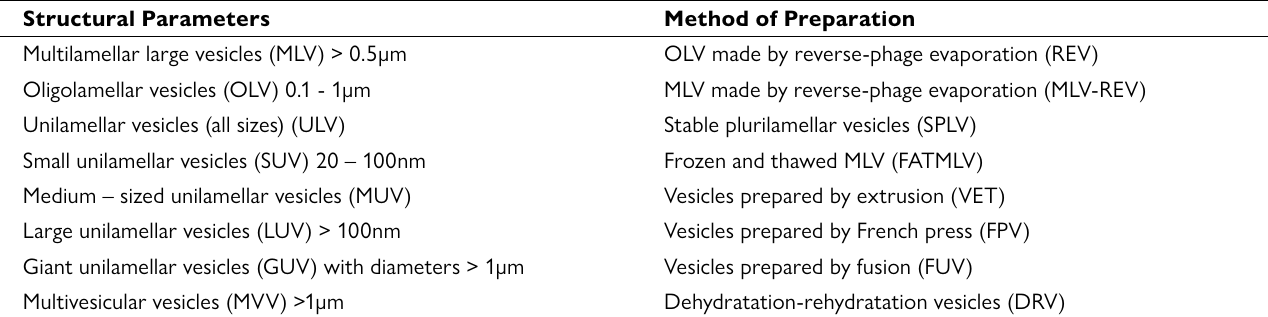
Table 1 Classification of liposomal delivery systems according to molecule size and mode of preparation.